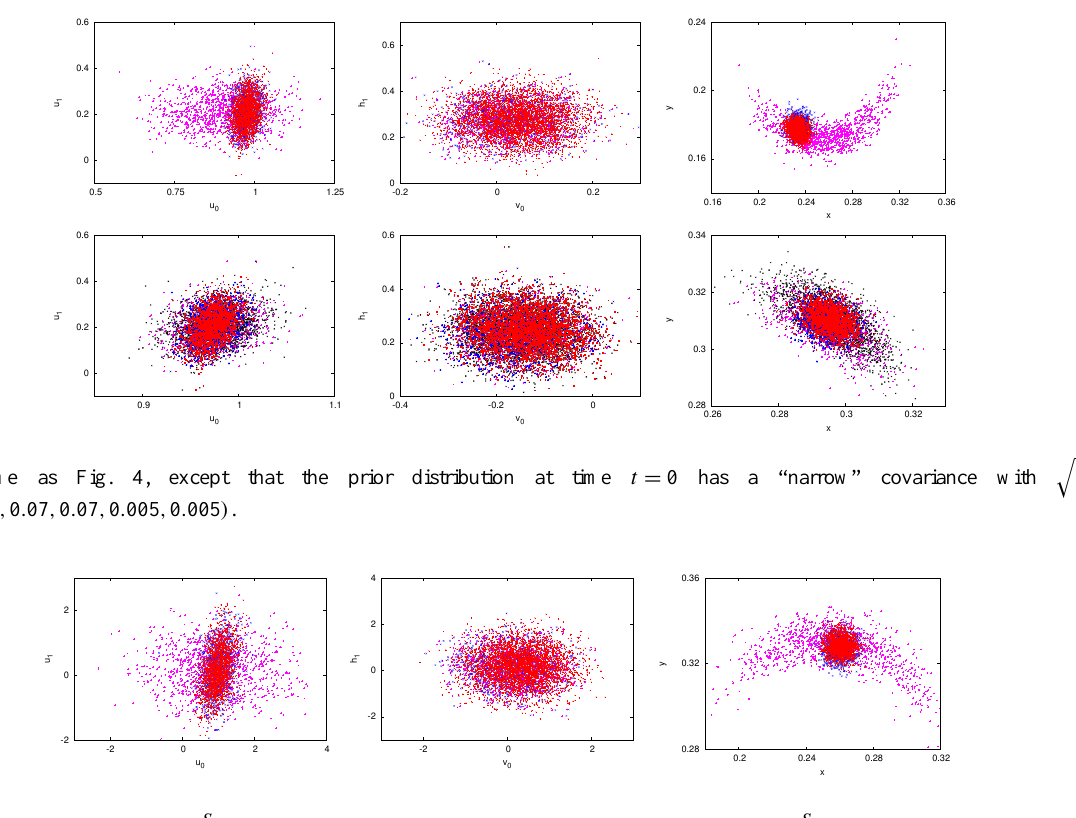
Fig. 6. Same as Fig. 4, except that T S obs =0 . 01 and distributions at only the first observation time t = T S obs =0 . 01 are shown. d s ( t ) , which in the case of data assimilation has the form Zupanski et al. (2007),